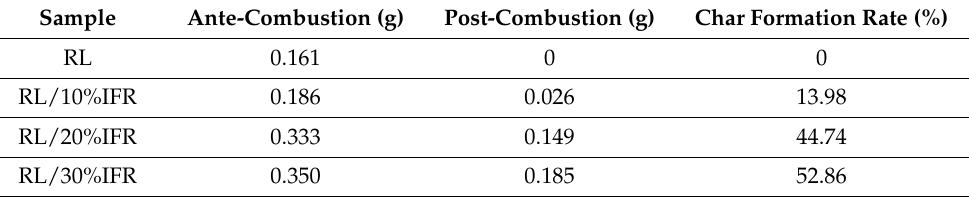
Table 1. Char formation rates of lacquer films with different FR